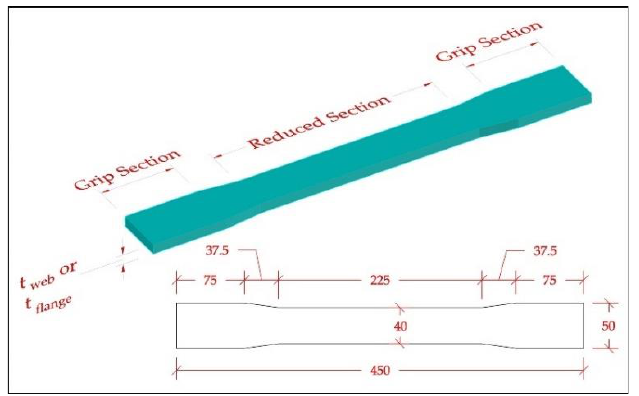
Figure 2. Geometry and dimensions of steel coupons (dimensions are in mm).